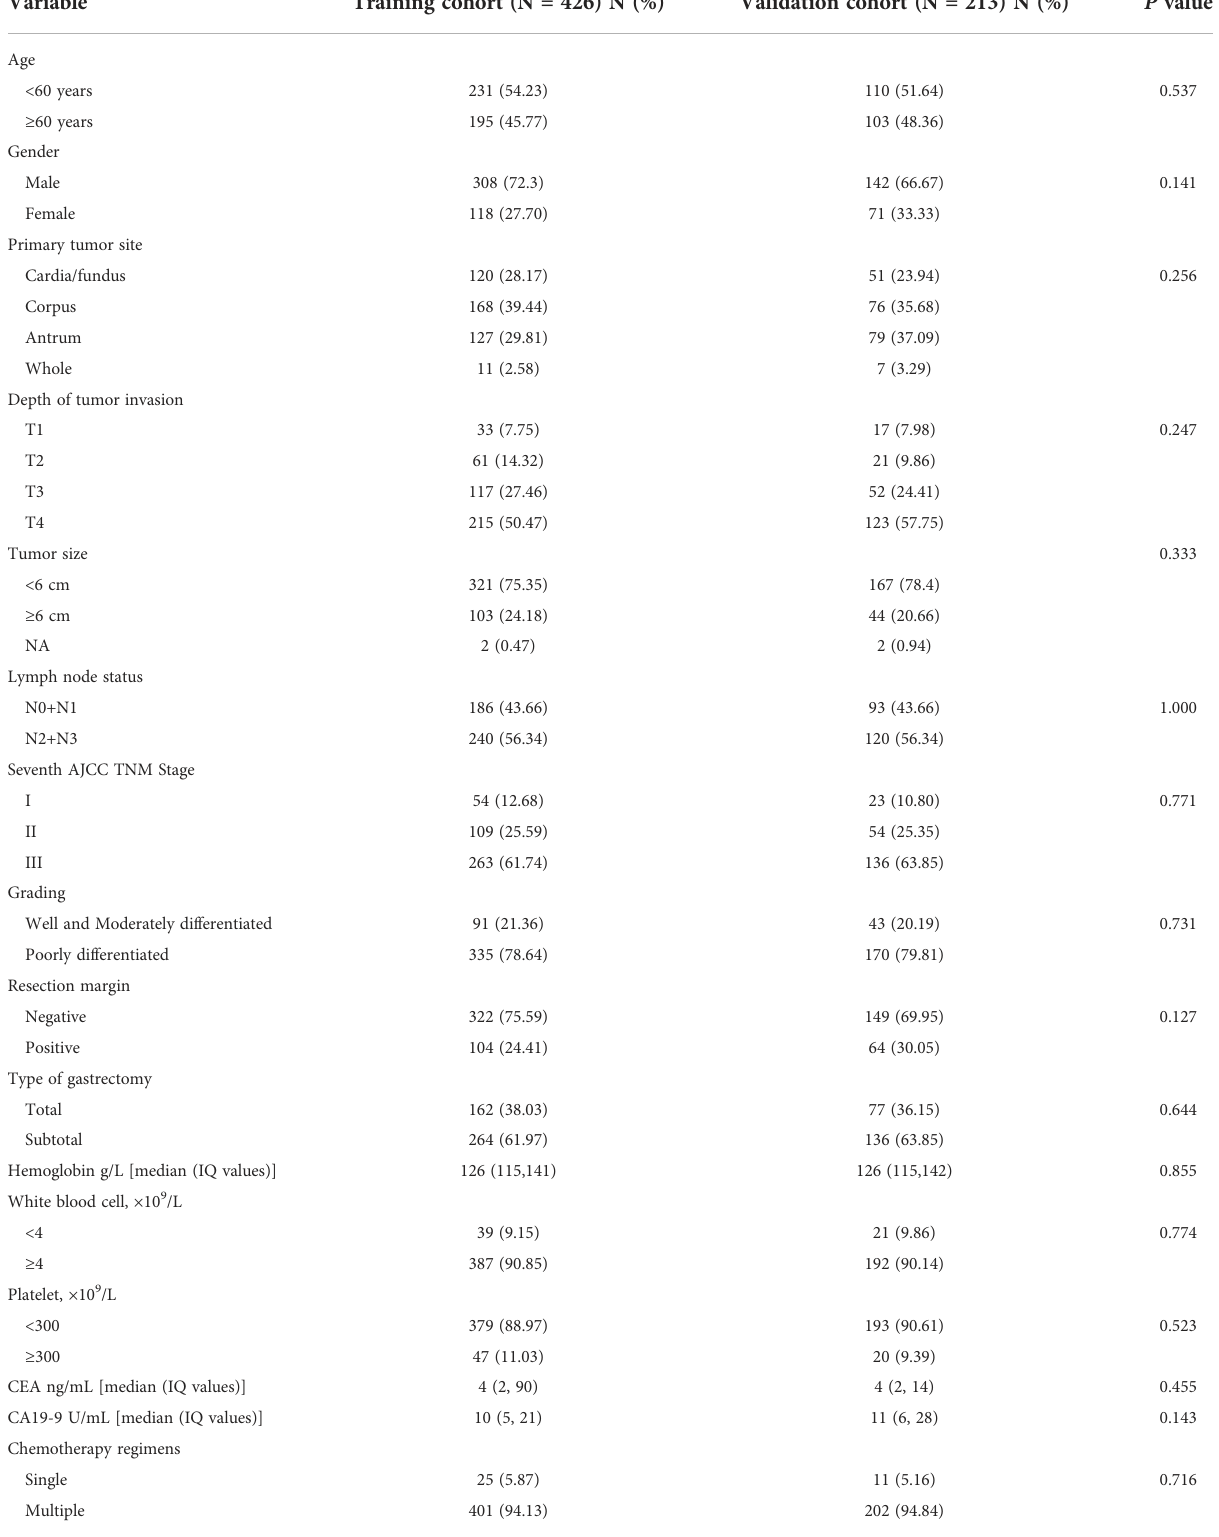
TABLE 1 Demographics for training cohort and validation cohort of patients with gastric cancer (N =